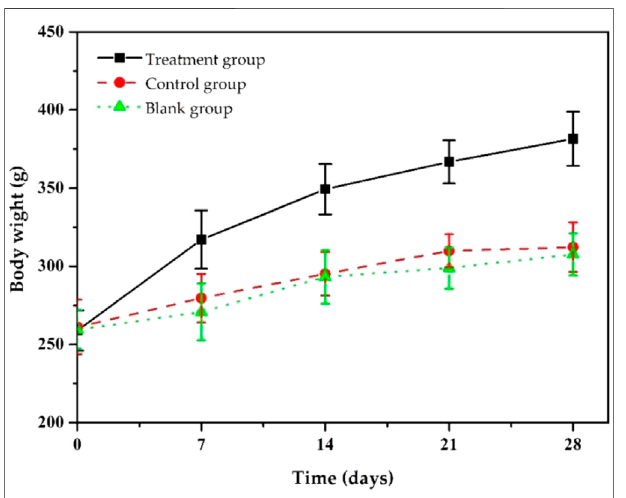
FIGURE 8 | Changes in body weights of chronic osteomyelitis model rats during treatment.